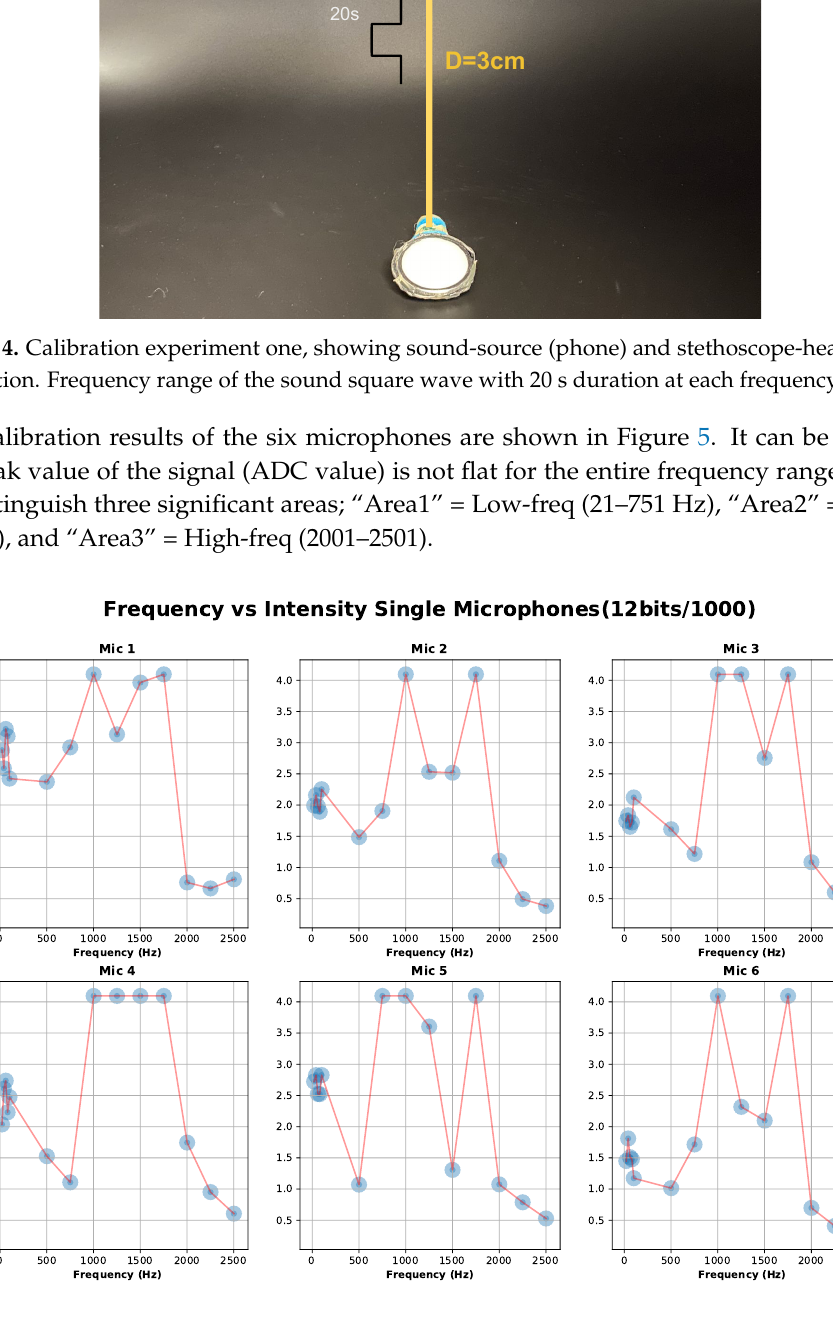
Figure 5. Calibration experiment one results: capture signal (ADC coded 12 bits) for each microphone-stethoscope for “Area1” = Low-freq (21–751 Hz), Area2 = Middle-freq (1001–1751) and Area3 = High-freq